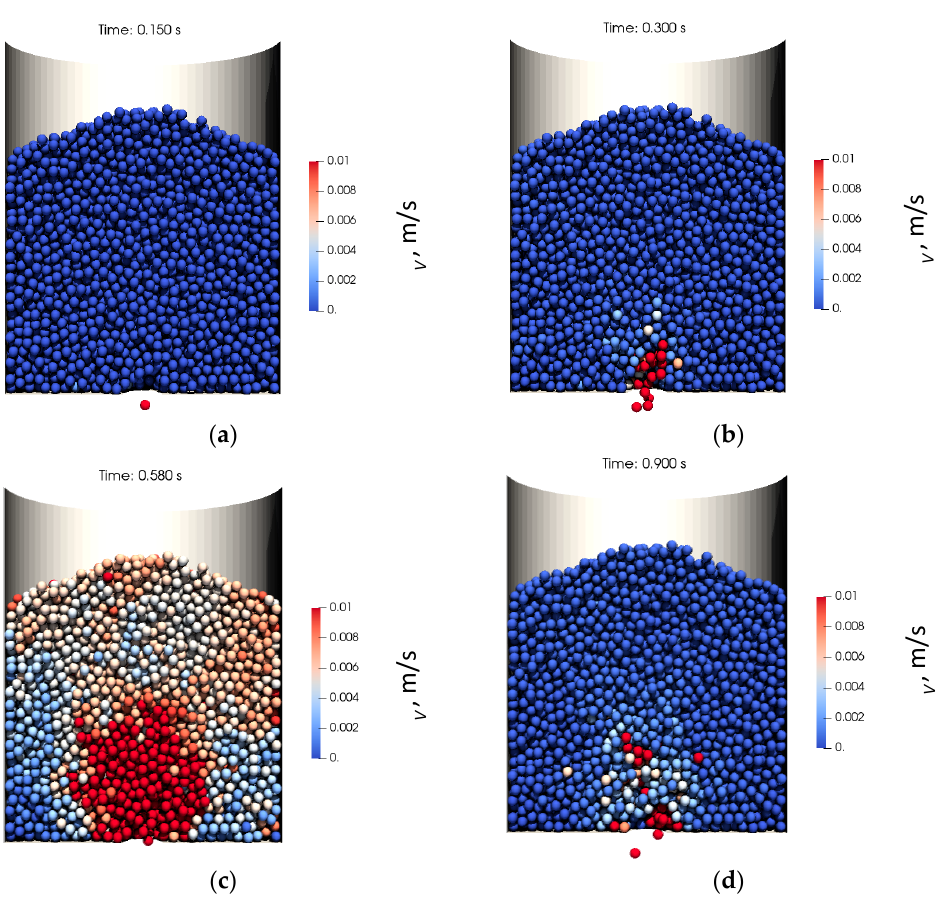
Figure 5. Cross-section of the bedding of unstable flow for an orifice size of 56 mm, after 0.15 s ( a ), 0.3 s ( b ), 0.58 s ( c ), and 0.9 s ( d ).